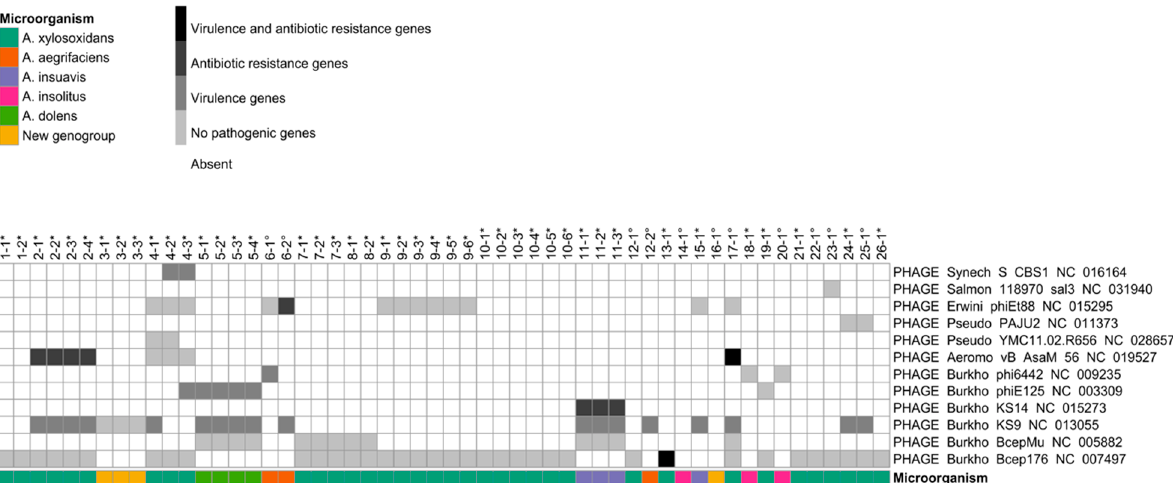
Figure 1. Phage analysis. The heatmap shows the presence of phages and the category of pathogenic genes that they carry (grey scale). The columns represent patients and isolates identification numbers. * indicates chronic infection isolates; ° indicates occasional infection isolates. Additional information regarding the microorganism species is represented in the annotation row (color scale) at the bottom.